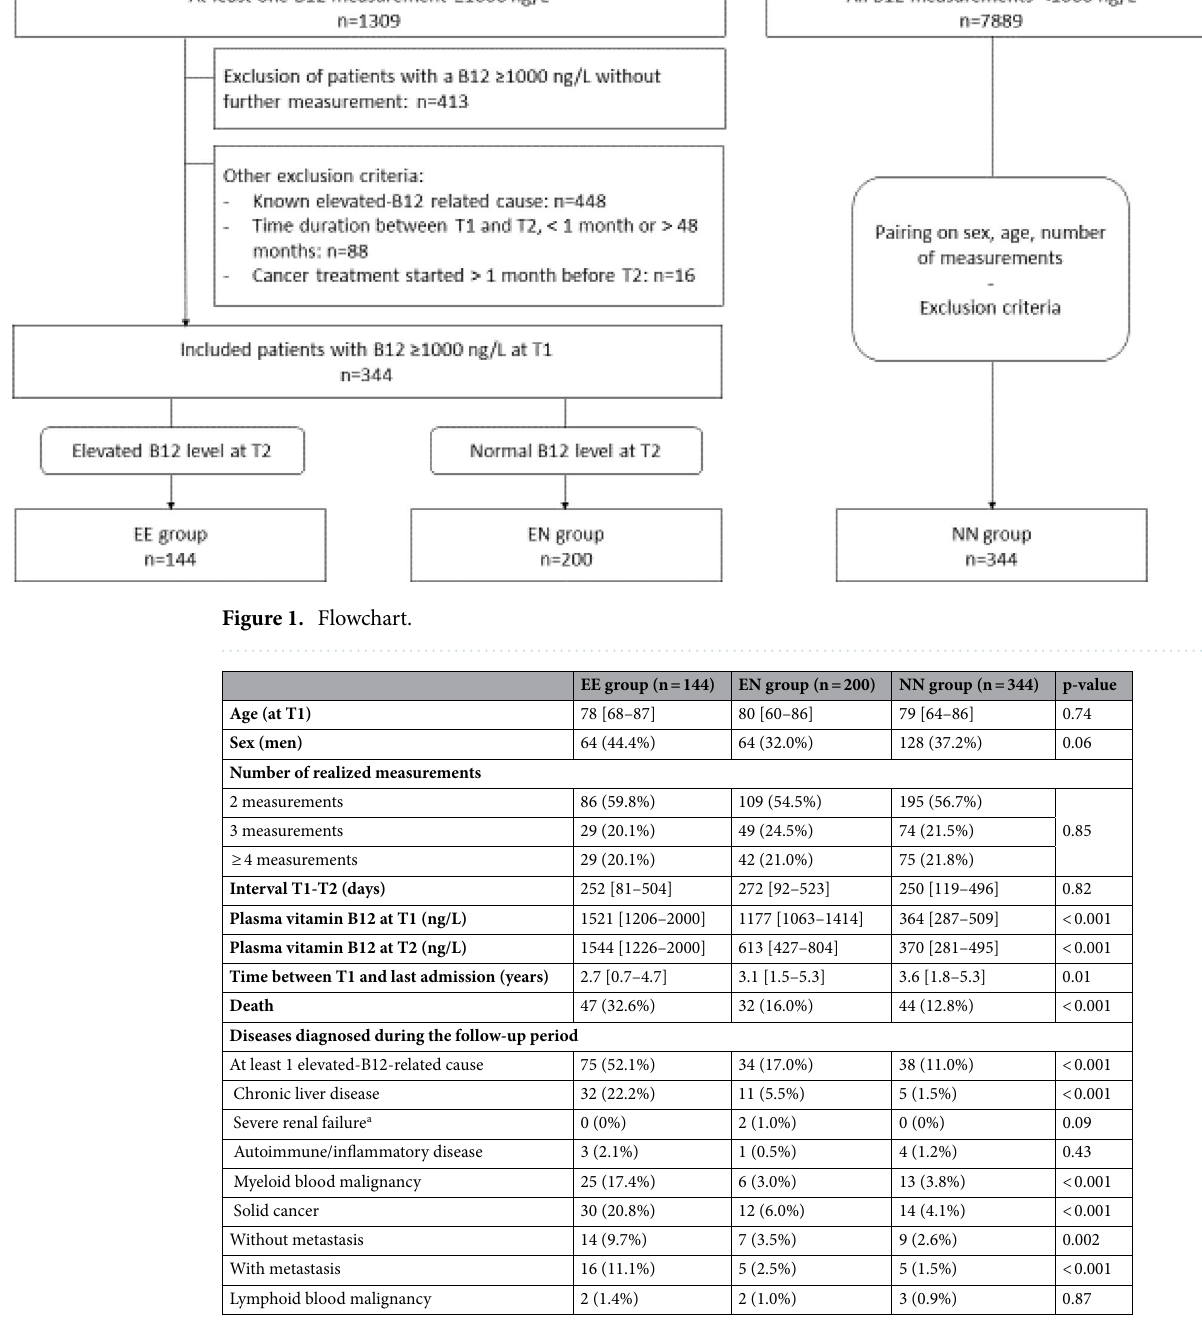
Table 1. Comparison of the 3 groups. The 3 groups were compared by ANOVA or Chi-squared test, as appropriate. a Creatinine clearance with MDRD formula ≤ 30 mL/min/1.73 m 2